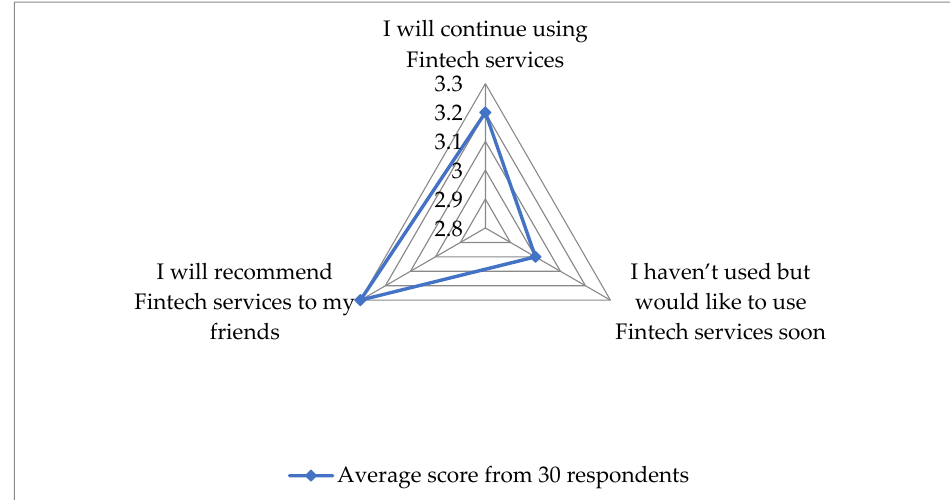
Figure 5. Fintech usage intention in Vietnam.